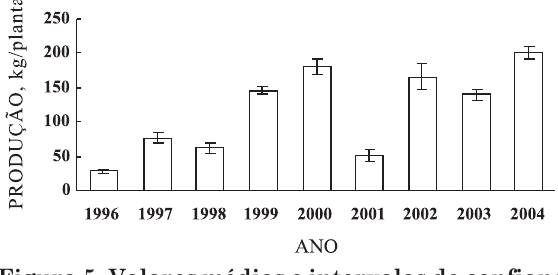
Figura 5. Valores médios e intervalos de confiança da média (p < 0,05) pelo teste t (barras verticais) da produção de laranja “Pêra” no período experimental